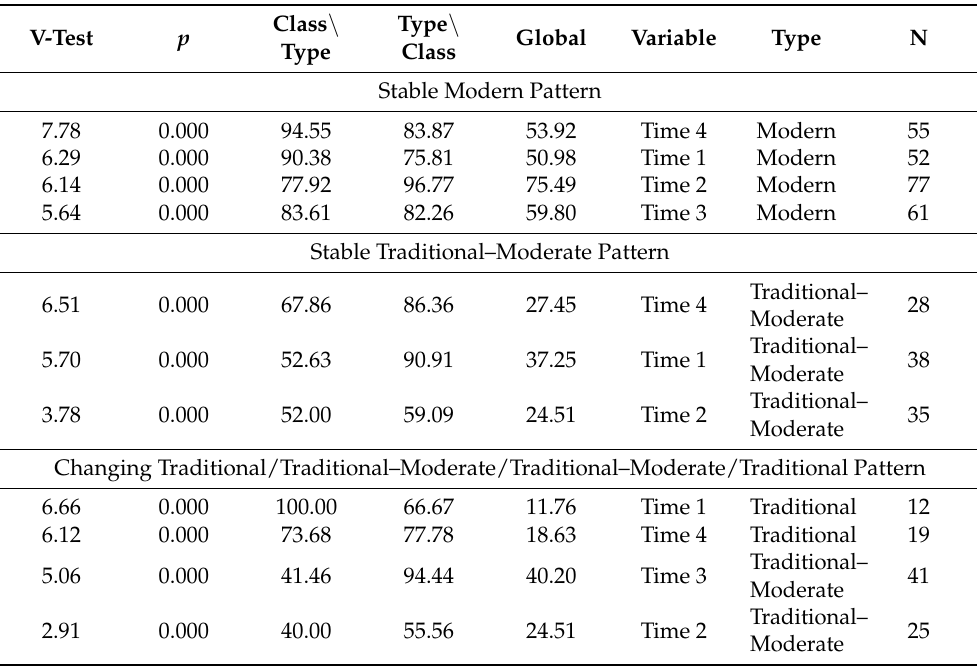
Table 3. Trajectories of ideas about childhood throughout the longitudinal